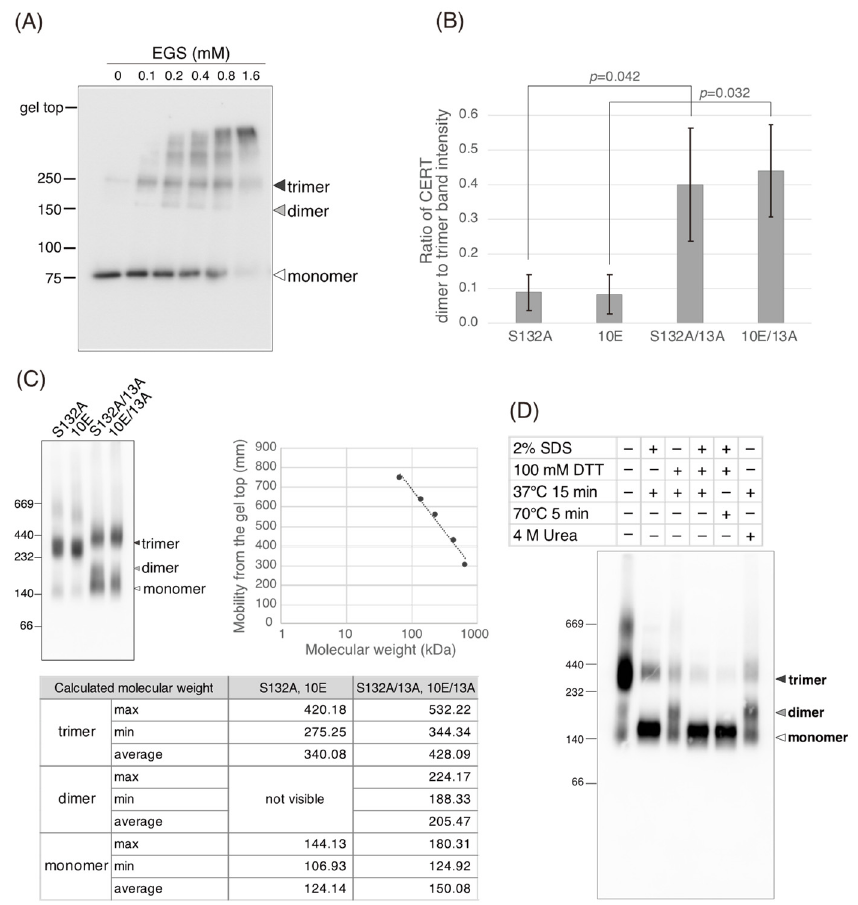
Figure 6. The 13A mutation partially destabilizes the trimeric state of CERT. ( A ) Recombinant CERT S132A, 10E, S132A/13A, and 10E were incubated with the vehicle solvent (DMSO) or EGS (0.1, 0.2, 0.4, 0.8, 1.6 mM) and, after terminating the reaction, aliquots (5 ng of protein) of the samples were subjected to western blotting analysis with an HRP-conjugated anti-HA rat monoclonal antibody. The western blotting image of S132A is shown as a representative example in the figure. See Figure S5A for all western blotting images. The acrylamide concentration used for the gel of SDS-PAGE was 6%. ( B ) The ratios of dimer to trimer CERT band intensity calculated from the experiment using 0.8 mM EGS in panel A and Figure S5 are shown as bar graphs. Significance was determined using a two-tailed Student’s t -test; p -values < 0.05 were considered statistically significant. ( C ) Quantities (10 ng) of recombinant CERT S132A, 10E, S132A/13A, and 10E/13A proteins were separated using blue native PAGE and detected with an HRP-conjugated anti-HA antibody. A calibration curve was drawn based on the molecular weight of each band of the marker and its mobility on blue native PAGE to quantify the molecular weight of each band in the recombinant CERT protein. Quantitative values are shown in the table. ( D ) Recombinant CERT S132A protein was incubated under various denaturing conditions, separated by blue native PAGE, and detected by western blotting analysis using an anti-HA antibody. Mysteriously, the mobilities of the monomers of these CERT variants in blue native PAGE were more consistent with the expected mobilities of dimers, rather than those of monomers, when compared with the molecular standard proteins used (Figure 6C). To verify that the lower bands of purified CERT S132A in the blue native PAGE patterns represented monomers, we pre-treated the purified CERT S132A under several different conditions and then analyzed the pre-treated CERT S132A using blue native PAGE (Fig- ure 6D). The pre-exposure to 2% SDS and 100 mM of the reducing reagent DTT almost completely diminished the trimer form and the trimer form converged to the lower band (Figure 6D), indicating that the lower band is the monomer of CERT in blue native PAGE, although its apparent mobility was slower than we expected. The precise reason for this